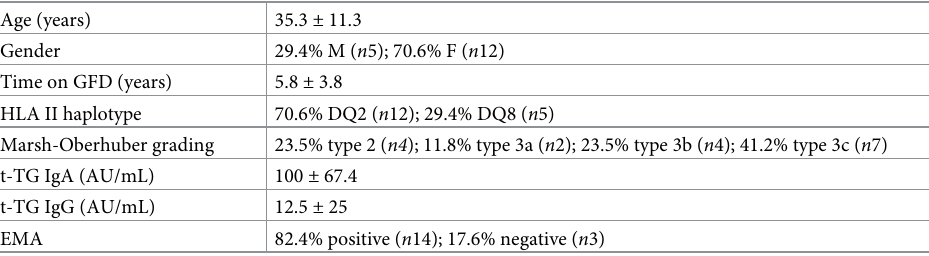
Table 1. Characteristics of celiac